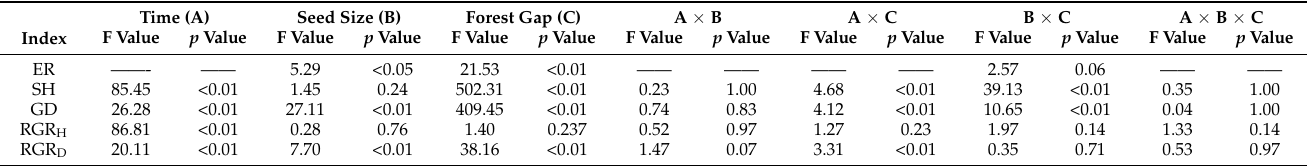
Table 1. Three-factor analysis of variance of time, seed size, and gap size on seed germination and seedling indexes of Quercus acutissima . ER: emergence rate; SH: seedling height; GD: ground diameter; RGR H : relative height growth rate; RGR D : relative ground diameter growth